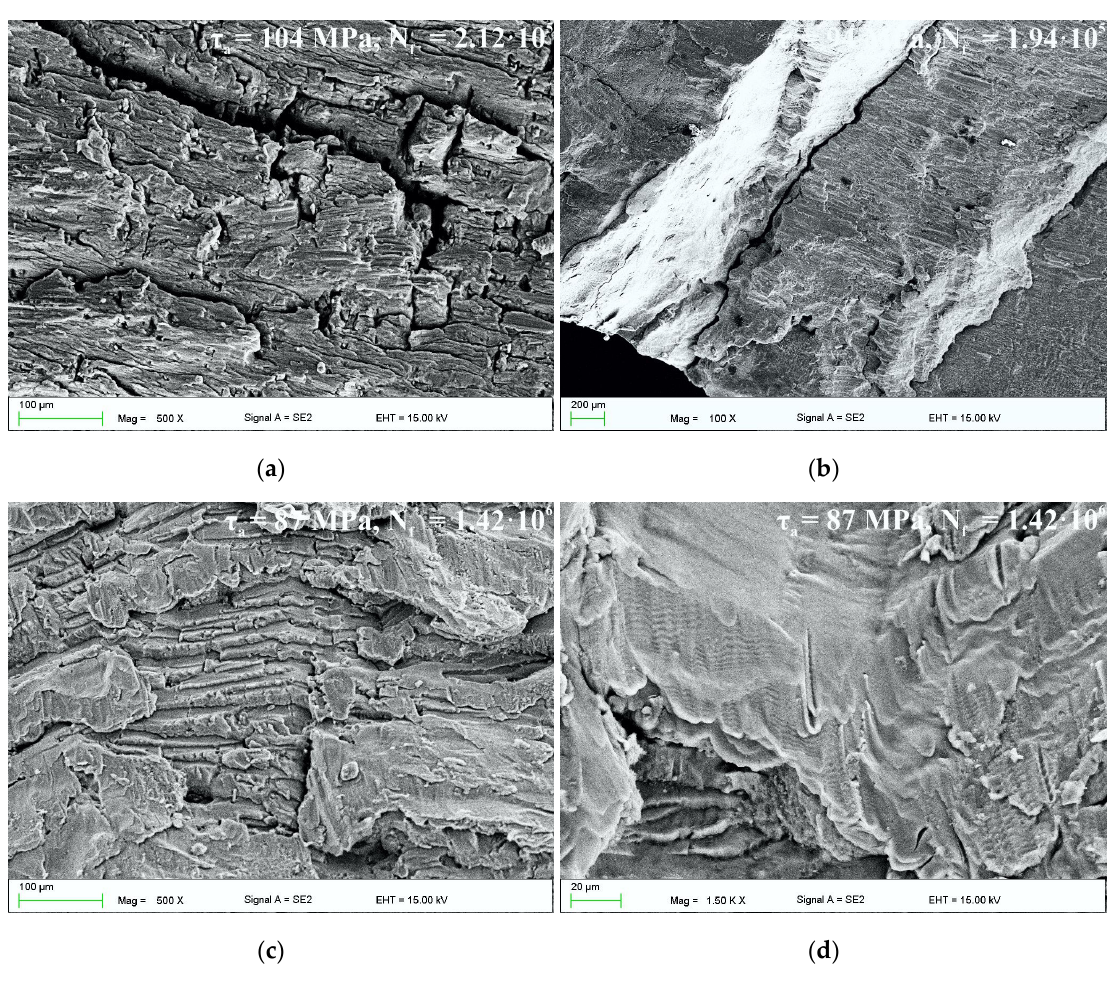
Figure 11. Fractures of fatigue test samples (double-sided torsion) of AlZn6Mg0.8Zr alloy, subjected to LTMP with 10% degree of deformation: ( a ) systems of secondary cracks on the cleavage planes; ( b ) focal point of fracture and primary fatigue crack on the specimen surface; ( c ) varied shape of jogs of the cleavage planes; ( d ) plastic fatigue strips on the jogs surface of crack planes.